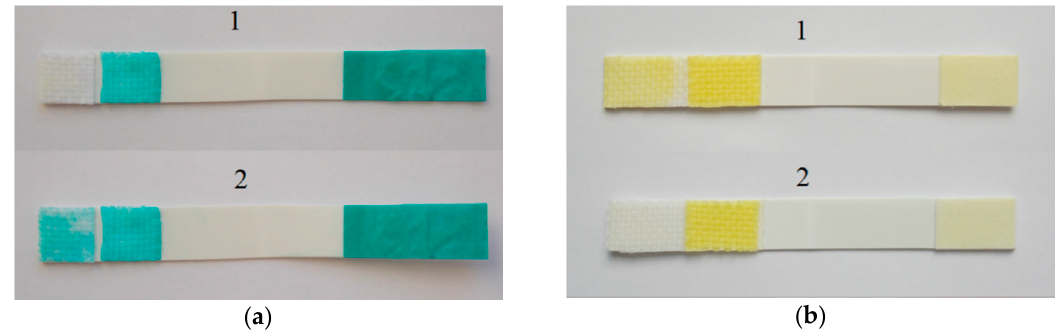
Figure 3. Photograph ( a ): the modified biosensor with a negative result (a1)—blank, and a positive result (a2)—the sample contains physostigmine at a concentration of 10 µg/mL. Both images immediately after separation of the carrier (T 0 = 120 s). For comparison, photograph ( b ) shows the standard Detehit biosensor with a negative (b1) and positive (b2) result.